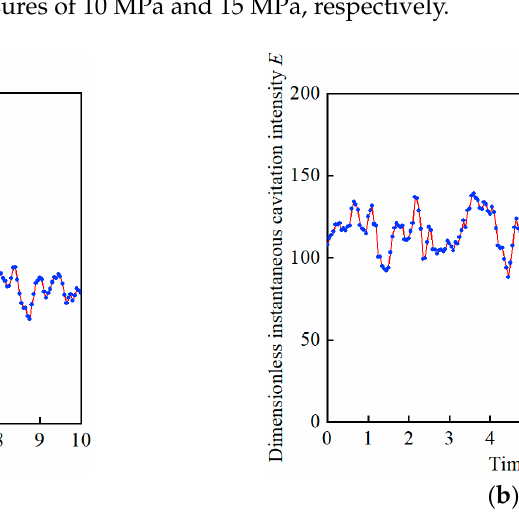
Figure 10. Fitting curve of dimensionless cumulative cavitation intensity and maximum mass loss.